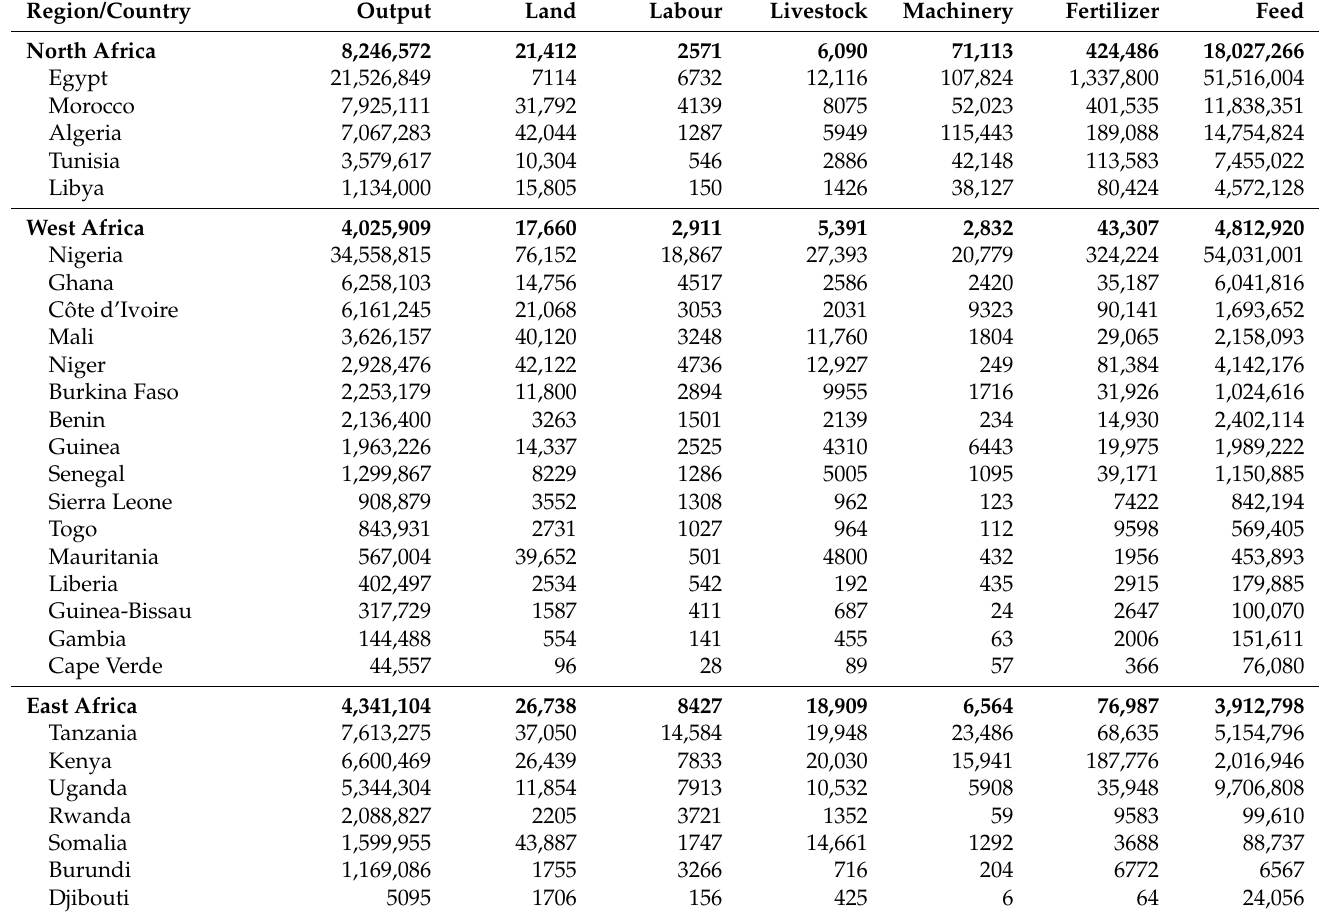
Table 2. Summary of output and input variables for 49 African countries for the period from 2000–